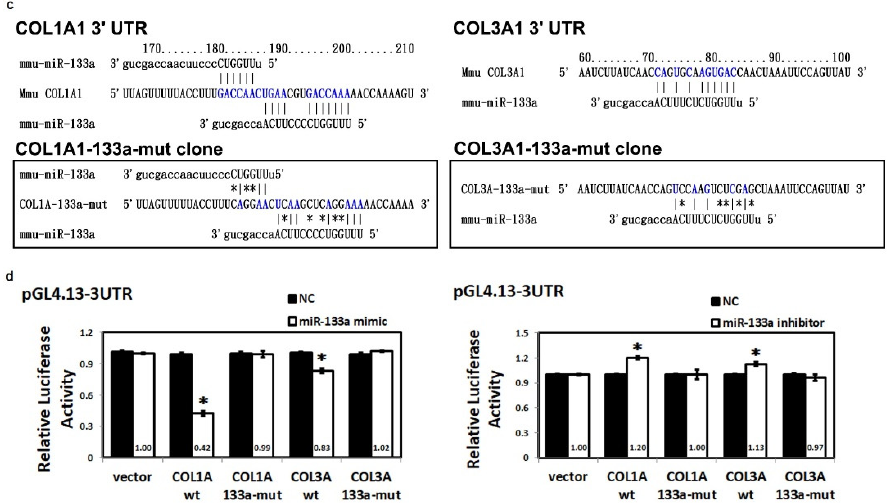
Figure 2. The miR133a and miR-let-7 family attenuated ECM markers through targeting collagen COL1A and COL3A. ( a , c ) The UCSC Genome Browser was used to align potential miRNA binding sites and mmu-miR-133a, mmu-let-7a and mmu-let-7e binding sites within the COL1A 3 (cid:48) UTR and COL3A 3 (cid:48) UTR. The COL1A 3 (cid:48) UTR and COL3A 3 (cid:48) UTR luciferase reporter constructs containing mutated target sites are shown with changes in the central nucleotides that should abolish binding of mmu-miR-133a or mmu-let-7 to the predicted target sites. miRNA binding sites were predicted using TargetScan and miRWalk. ( b , d ) Cells were transfected with a firefly luciferase and β -gal reporter construct, which contained 3 (cid:48) UTR of COL1A or COL3A mRNA, along with either miRNA mimic, miRNA inhibitor or negative control (NC). For the mutant firefly luciferase reporter, putative miR- 133a, miR-let-7a or miR-let-7e binding sites in 3 (cid:48) UTR regions were also detected and normalized to beta-galactosidase reporter. Data are presented as mean ± standard error from at least three separate experiments. * p < 0.05 compared with the NCs. (COL1A = collagen type 1A1, COL3A = collagen type 3A1, UCSC = University of California, Santa